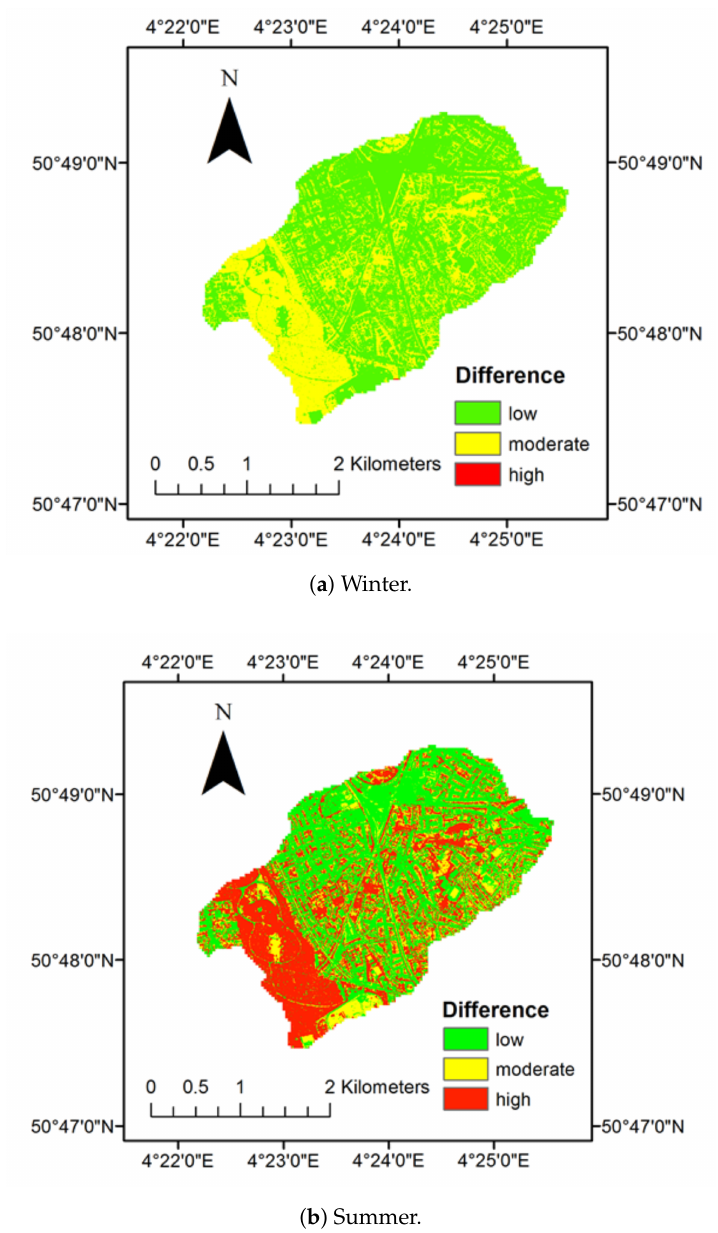
Figure 11. Spatially-distributed comparison between WetSpaClassic and WetSpaLAI for interception storage for the Watermaelbeek in 2015 (low <3 mm, moderate <5 mm, high <15 mm, absolute values). ( a ) January to March and October to December represent winter (WetSpaLAI higher). ( b ) April to September represent summer (WetSpaLAI